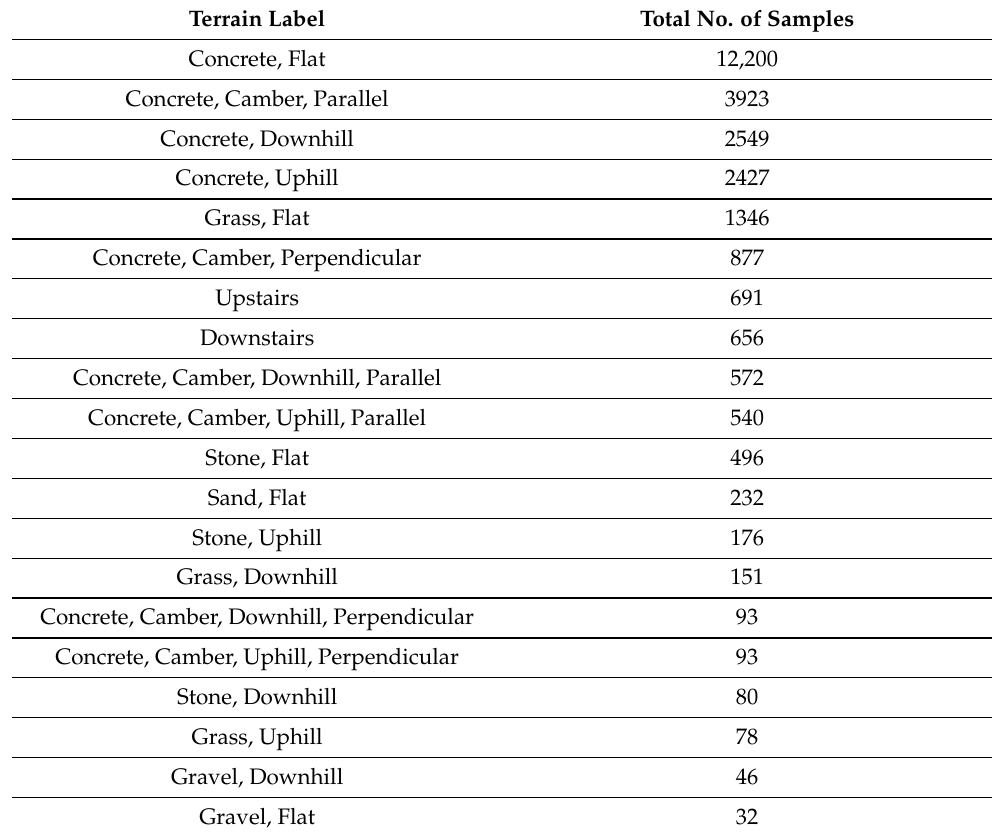
Table 1. List of all collected activities in investigation and their total corresponding sample counts. Terrain Label Total No. of